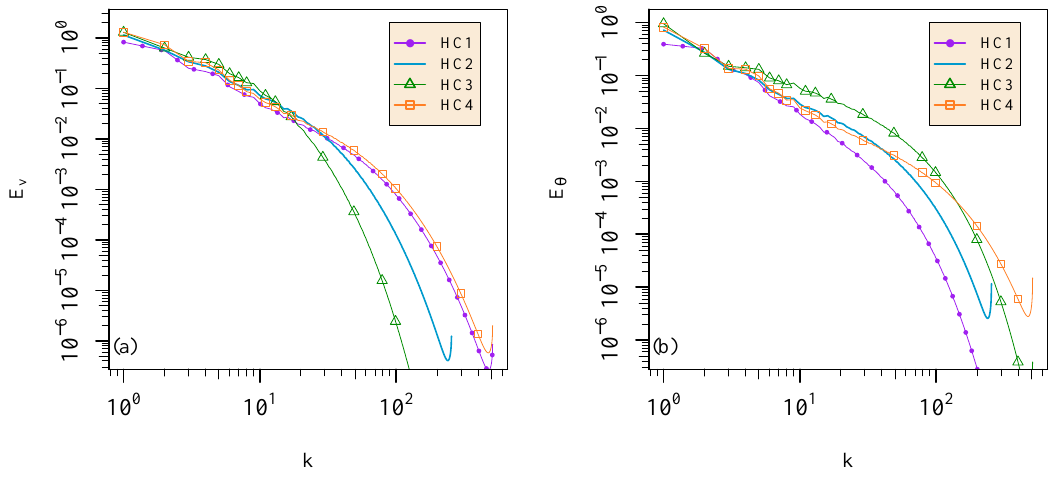
Figure 2. Kinetic energy spectrum E v ( a ) and thermal energy spectrum E θ ( b ) for simulations HC1, HC2, HC3, and